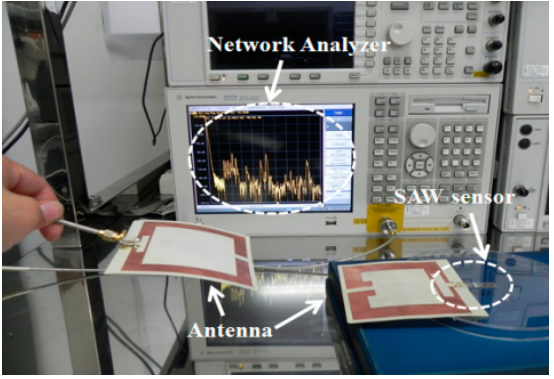
Figure 7. Wireless measurement of the fabricated biosensor with two antennas.